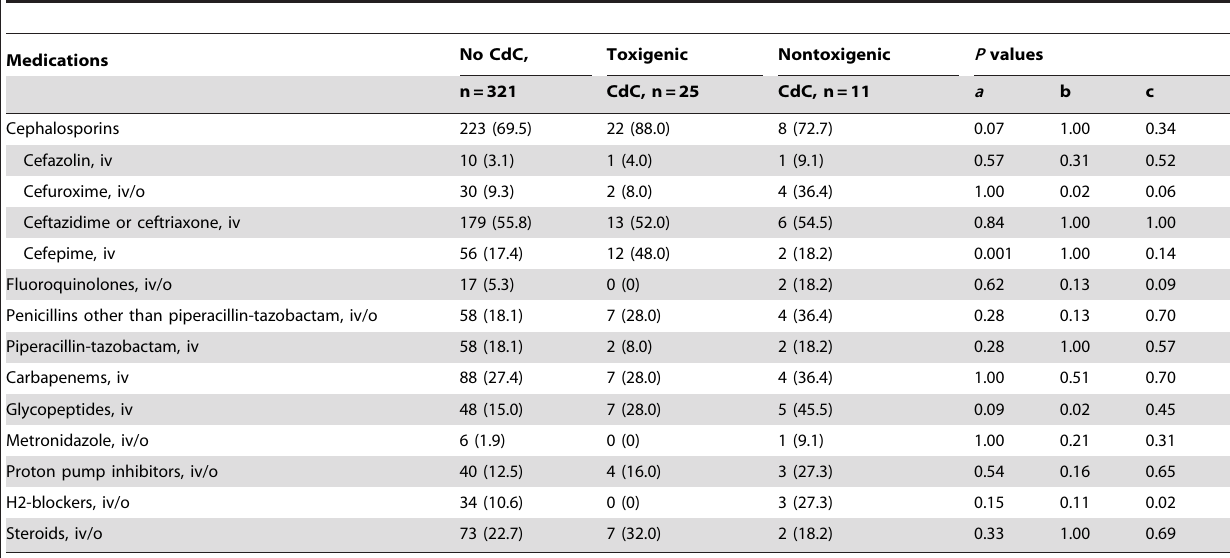
Table 3. Medications during hospitalization in 357 patients without Clostridium difficile colonization (CdC) at admission, stratified by the presence or absence of toxigenic or nontoxigenic CdC in the feces after admission.